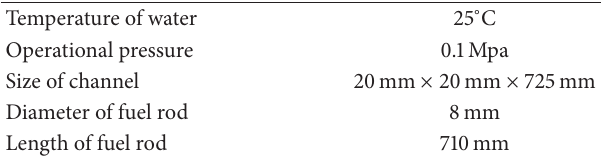
Table 2: Experimental conditions and geometry parameters of the test